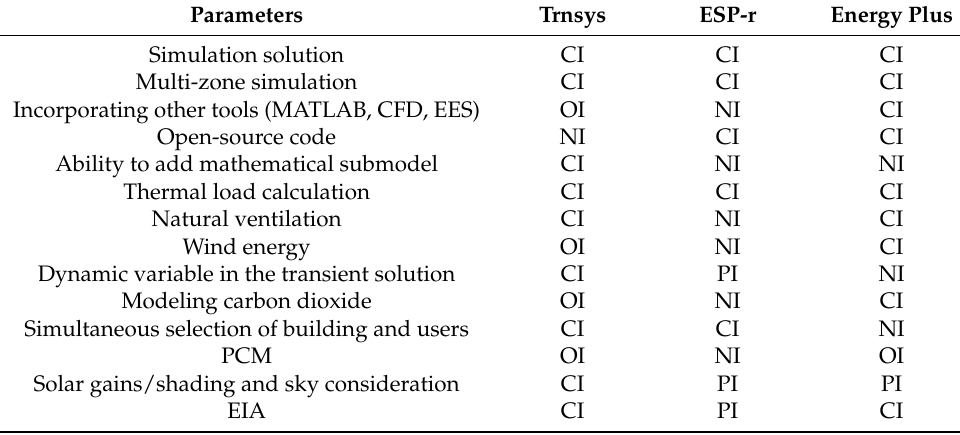
Dynamic variable in the transient solution Simultaneous selection of building and